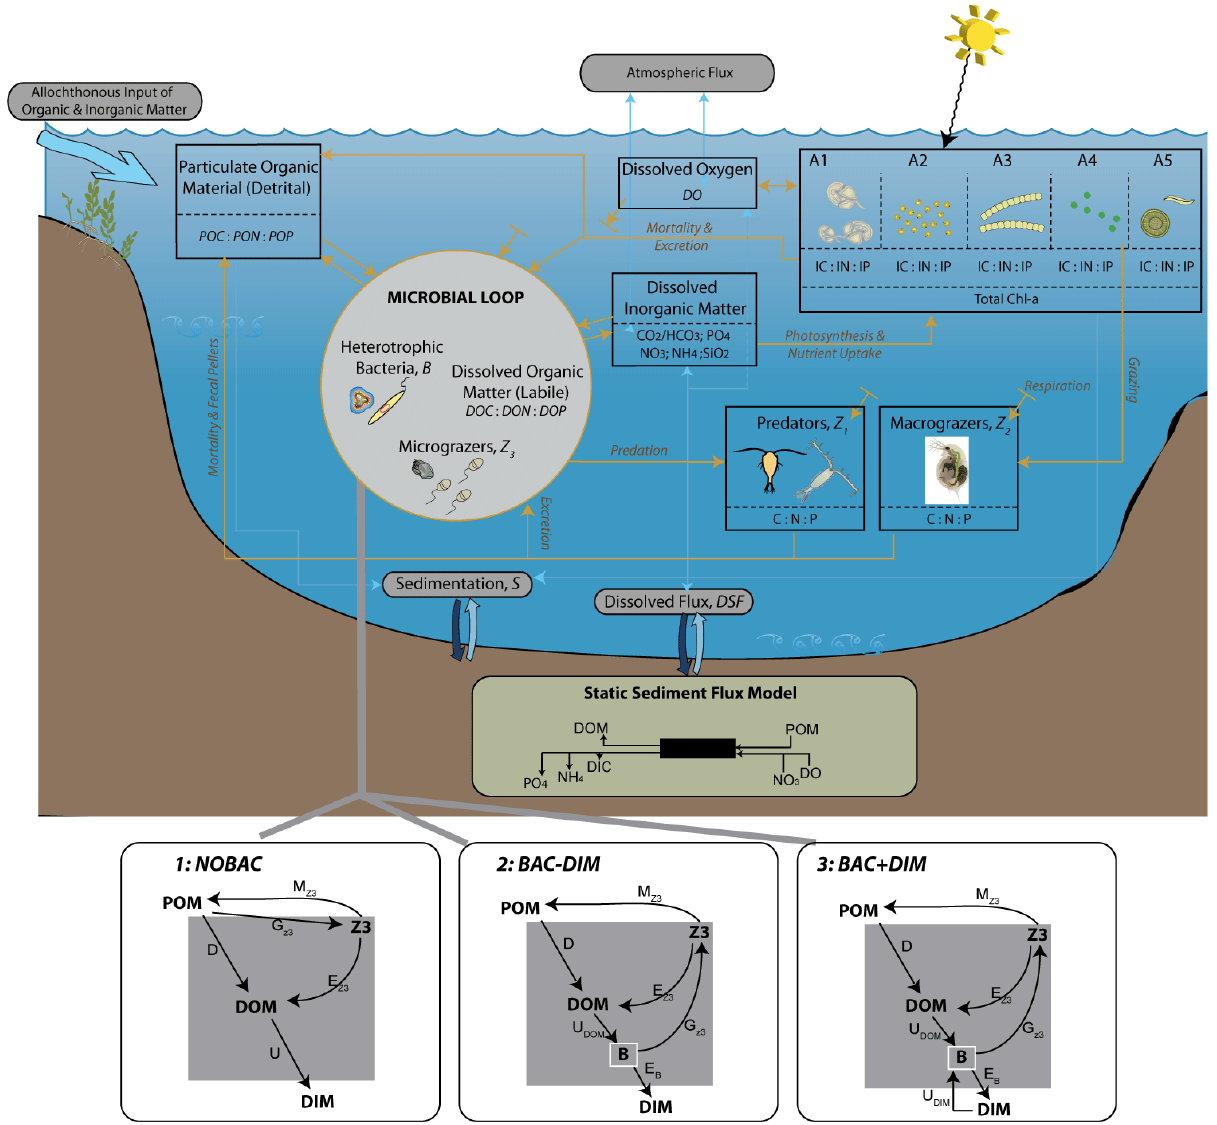
Figure 1. Conceptual diagram highlighting the general ecosystem model (CAEDYM) configuration for Lake Kinneret (top) and processes and feedbacks for the three microbial loop models (bottom) explored in this study: (1) NOBAC, (2) BAC − DIM, and (3) BAC+DIM (refer to Tables 1 and 3 for